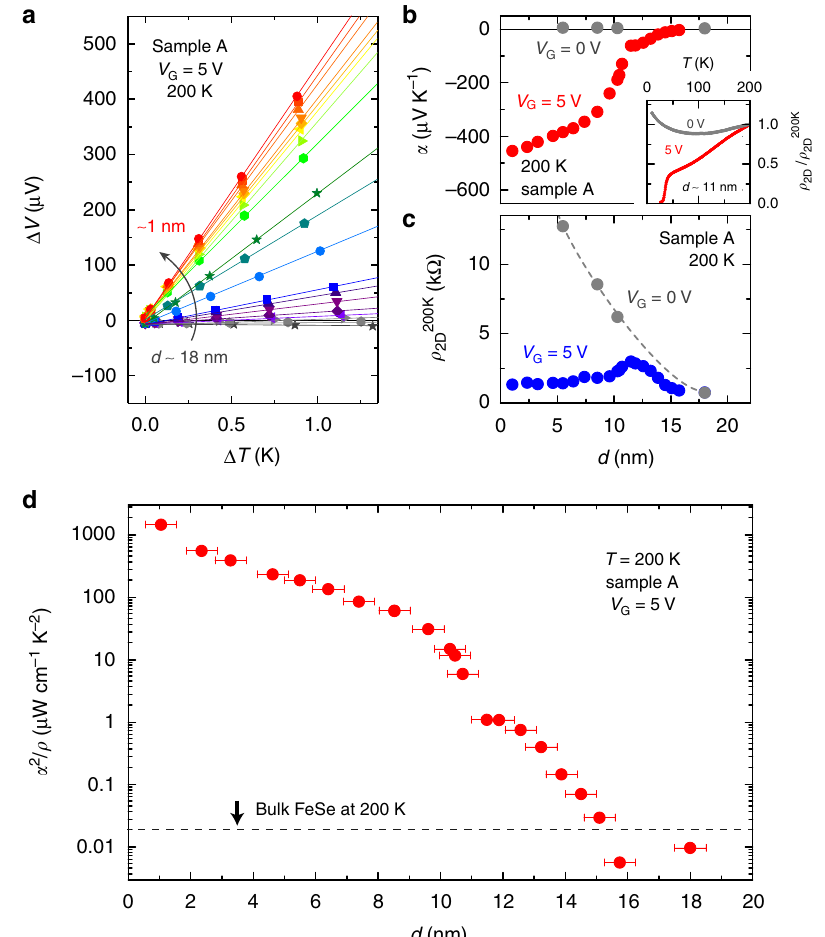
Fig. 2 Thinning-induced enhancement of thermoelectric effect. a Thermoelectric voltage Δ V under temperature difference Δ T in an FeSe thin fi lm, Sample A. The thermoelectric measurements were performed at 200 K with V G = 5 V. The value of Δ V changed its sign and dramatically increased with decreasing thickness d from ~18 nm to ~1 nm. b Thickness d dependence of the Seebeck coef fi cient α . The values of α were estimated from the slope of the Δ V − Δ T plot in a as α = − Δ V/ Δ T . The inset shows the temperature T dependence of the normalized sheet resistance ρ Superconductivity appeared when V G = 5 V was applied. c Variation of sheet resistance ρ 2D 200K at 200 K as a function of d . The value of ρ 2D 200K for V G = 5 V showed a weak d dependence (blue circles), whereas that for V G = 0 V increased with decreasing d (gray circles). d Thickness d dependence of thermoelectric power factor α 2 / ρ exhibiting anomalous enhancement in the ultrathin limit. Here, ρ is the electrical resistivity, which is estimated as ρ = ρ d . The value of α 2 / ρ at 200 K in the thick region is comparable to that in bulk FeSe 19 , whereas α 2 / ρ increased with decreasing d because of the 2D × double-digit increase of α in ultrathin regions in b . The error bar of d corresponds to ~ ± 0.5 nm, which was estimated from the surface roughness of the initial thin fi lm